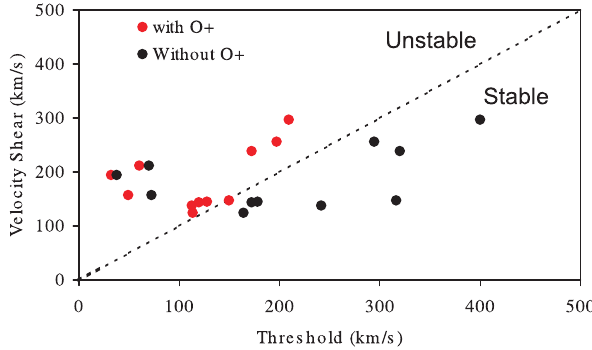
Fig. 13. Scatterplots of the shear flow velocity as a function of the velocity threshold given by the right-hand side of Eq. (3) when considering H + ions only (black rounds) and when adding the O + component (red rounds) into the calculation. In the region above the dotted line, the instability criterion is